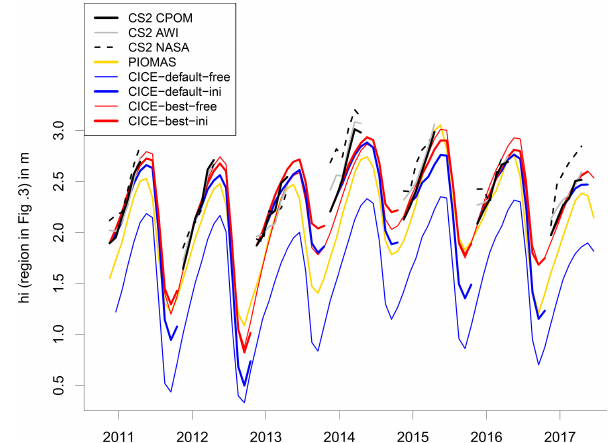
Figure 8. Mean effective sea ice thickness over the region shown in Fig. 3. Verification of CICE-free default and best (thin lines) and CICE-ini default and best (thick lines) with CS2 CPOM, AWI, NASA, and PIOMAS.